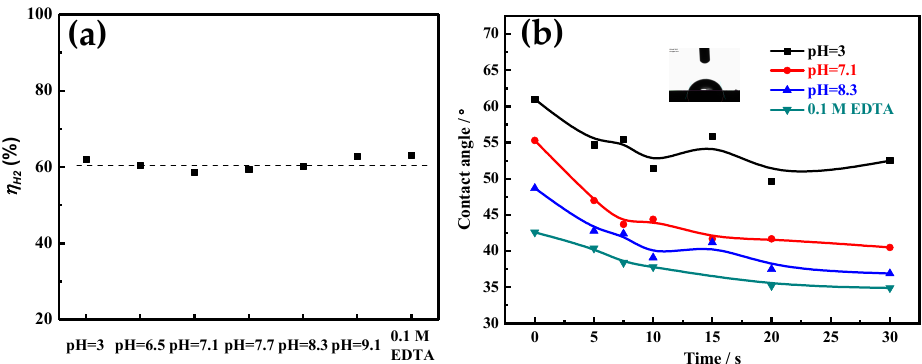
Figure 8. ( a ) The current efficiencies of HER for different Ni electrodeposition solutions. ( b ) Time-dependent interface contact angle ( Φ ) evolution of different solutions during the Ni electrodeposition process.